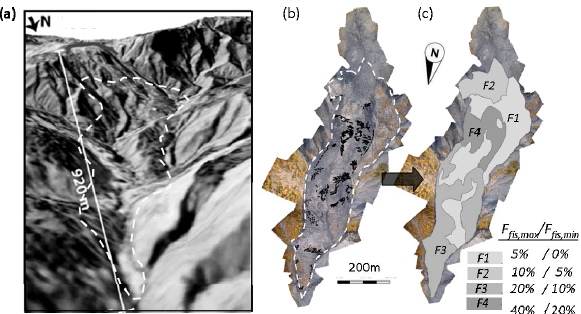
Figure 4. (a) The DEM of Super-Sauze landslide area from 1956, before the initial failure of the slope with